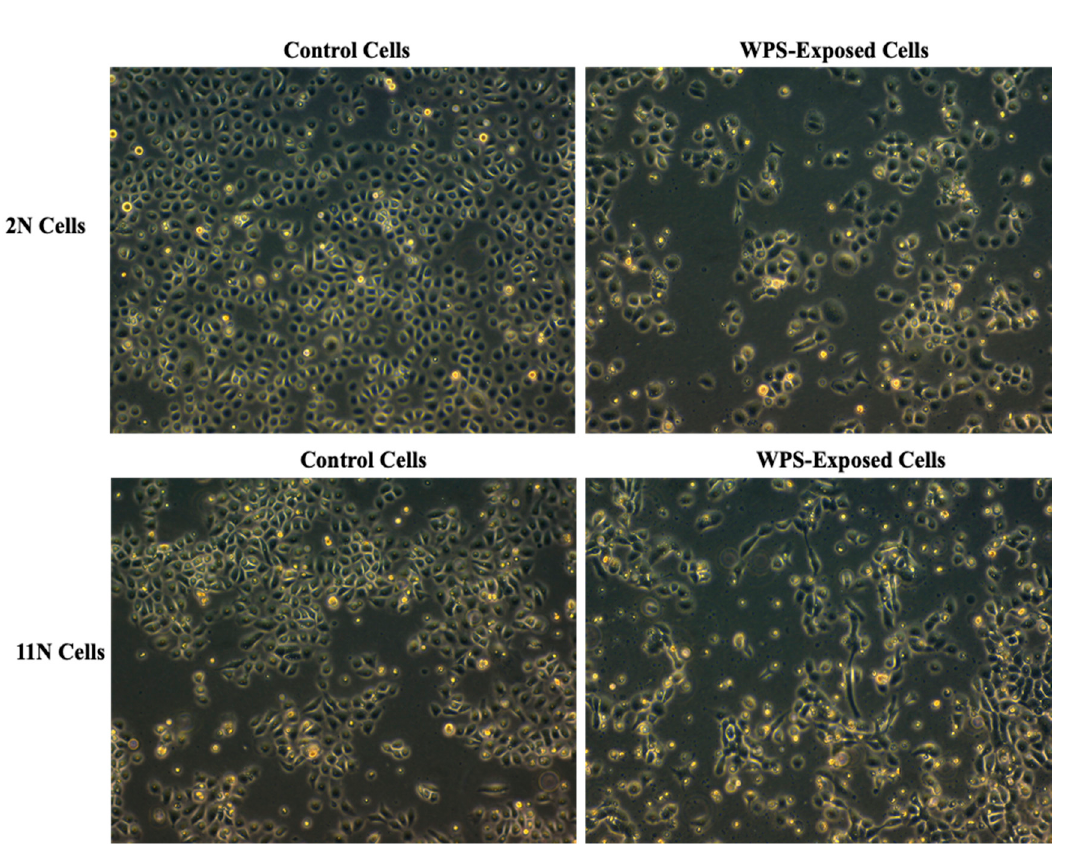
Figure 1. Water-pipe smoking (WPS) stimulates epithelial–mesenchymal transition (EMT) of human normal oral epithelial (HNOE) cell lines, 2N and 11N. We note that treatment for 2 days with 100 μ g/mL of WPS solution induces morphological changes from epithelial (control) into a “fibroblast-like” (mesenchymal) phenotype, which is known as EMT.